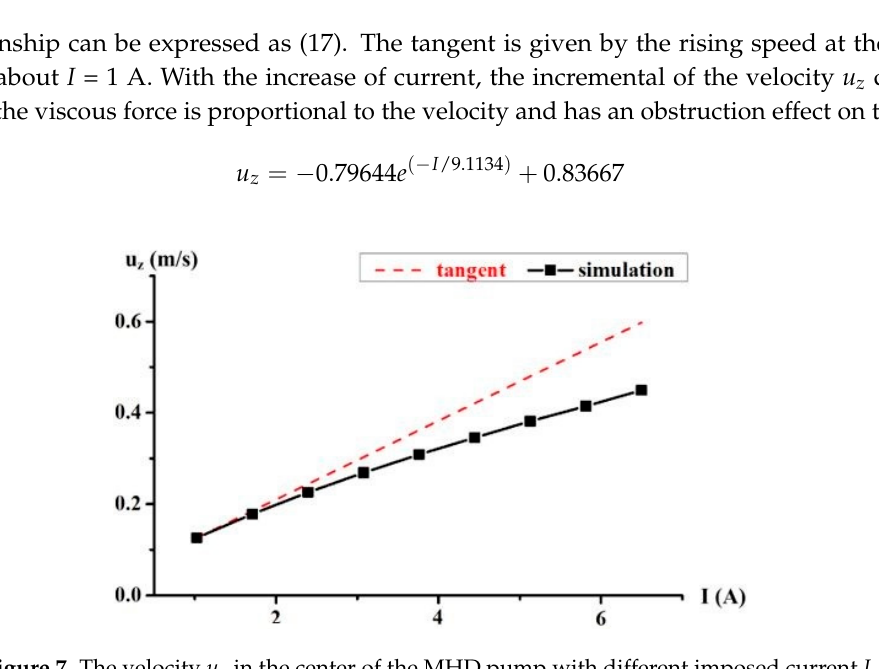
Figure 7. The velocity u z in the center of the MHD pump with different imposed current I .